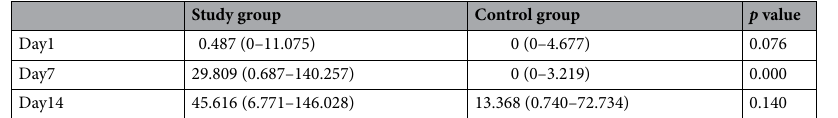
Table 2. The concentration of salivary sIgA of the study population (μg/ml). Datas were expressed as M (P25 ~ P75).